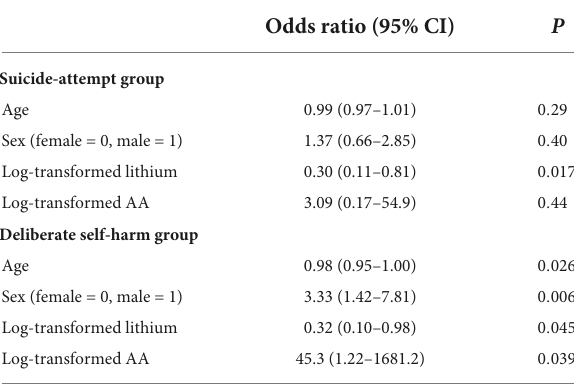
TABLE 4 Multivariate logistic regression analyses of lithium and AA in the suicide-attempt group and deliberate self-harm group with the control group as a